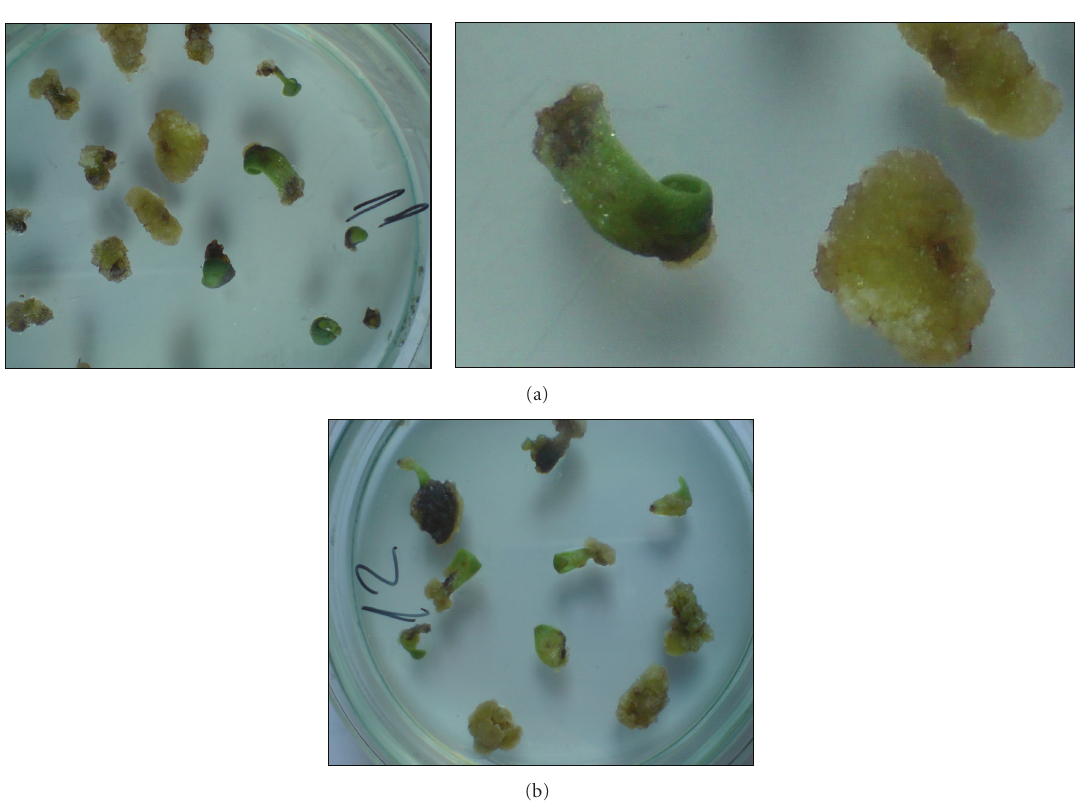
Figure 11: Callus cultures cultivated for 40 days on di ff erent media: variant (a) MS medium enriched with 1mg/L BAP, 0.5 mg/L NAA and